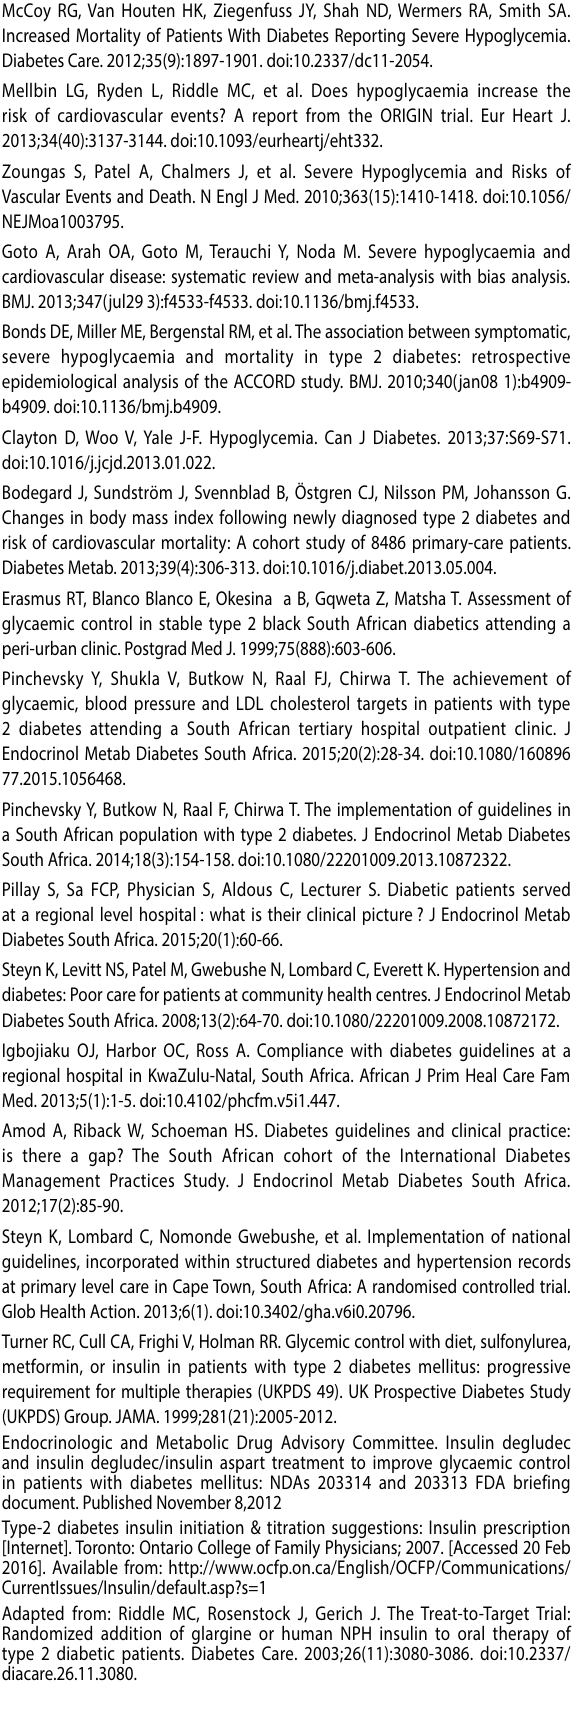
The page number in the footer is not for bibliographic referencingwww.tandfonline.com/oemd